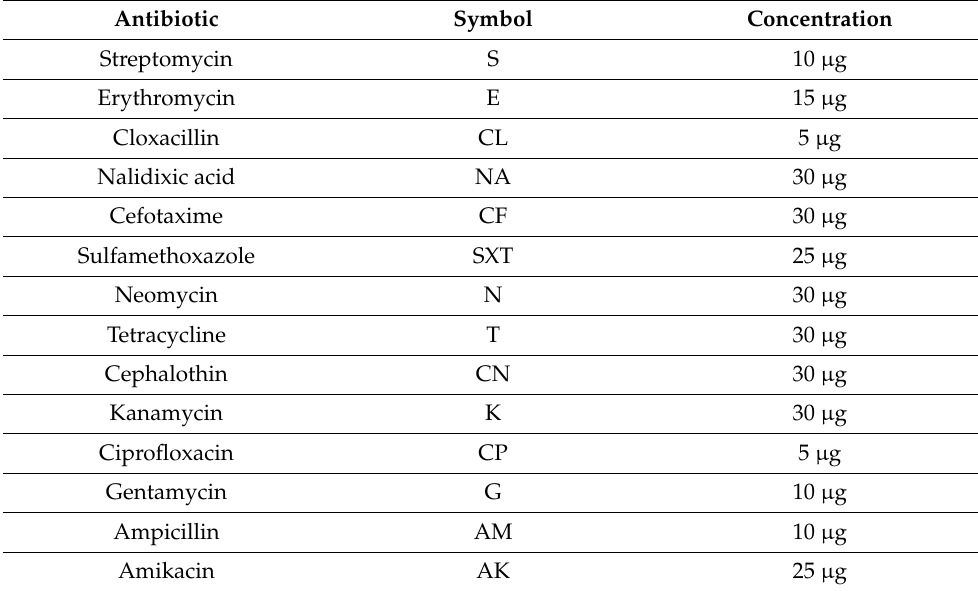
Table 5. Antimicrobial discs used for V. parahaemolyticus and A. hydrophila. Antibiotic